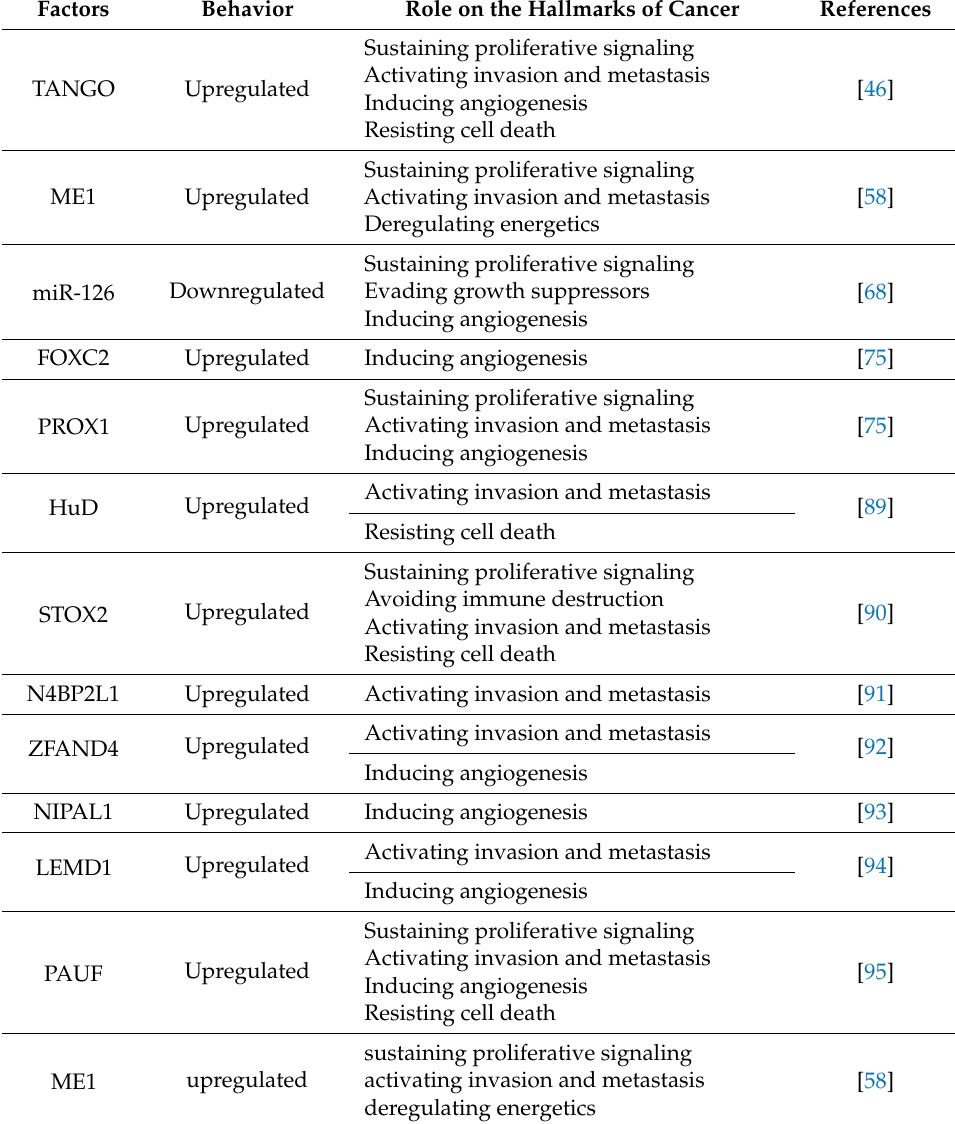
Table 1. Functional roles of novel prognosticators of oral squamous cell carcinoma (OSCC). Factors Behavior Role on the Hallmarks of